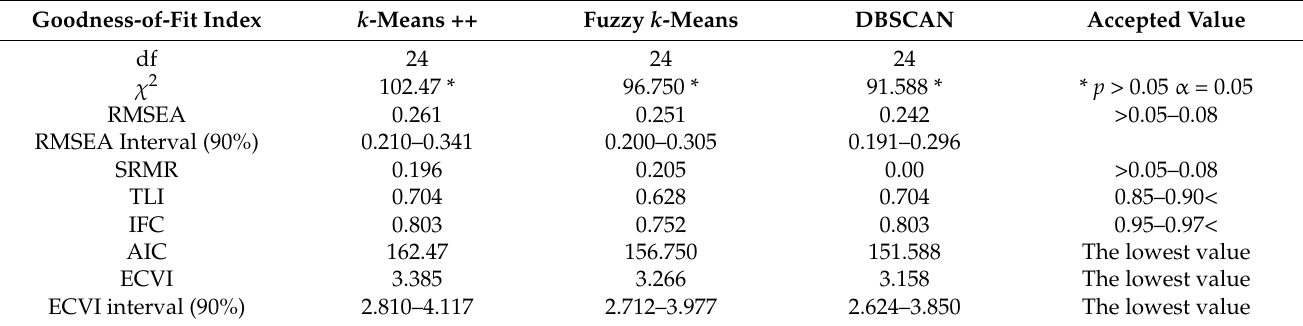
Table 3. Goodness-of-fit indexes of the k -means ++, fuzzy k -means and DBSCAN algorithms.